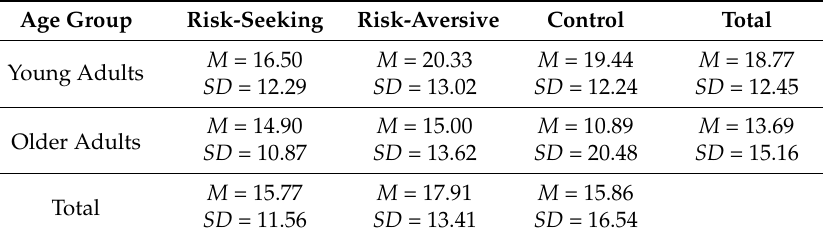
Table 1. Age and scenario differences in risk